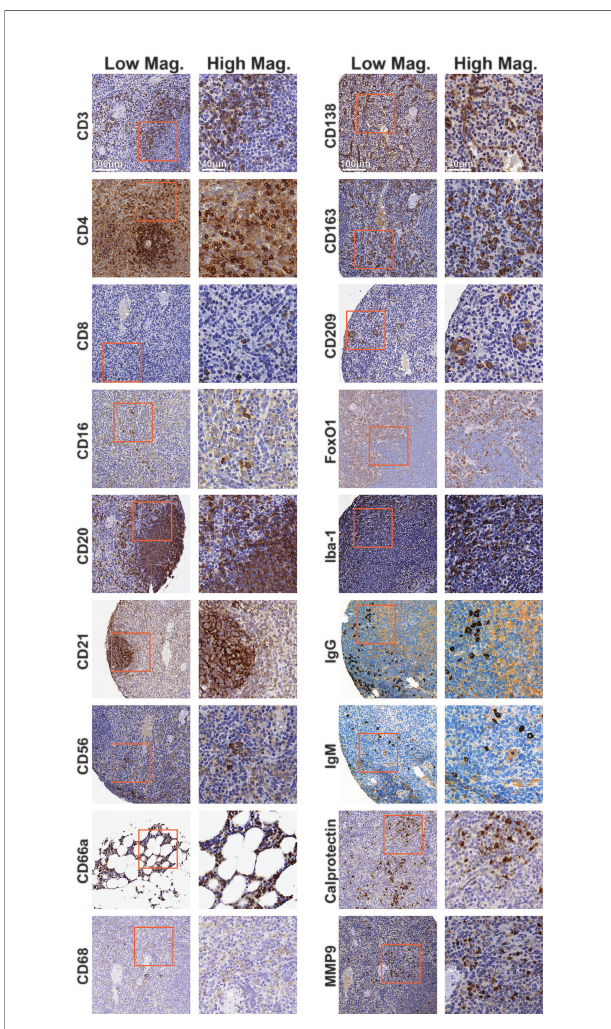
FIGURE 2 | Immunohistochemistry validation of antibodies targeting rhesus immune tissues. Representative low magni fi cation (left) and high magni fi cation (right) IHC images for indicated markers. Inlaid orange boxes on low magni fi cation images indicate the magni fi ed